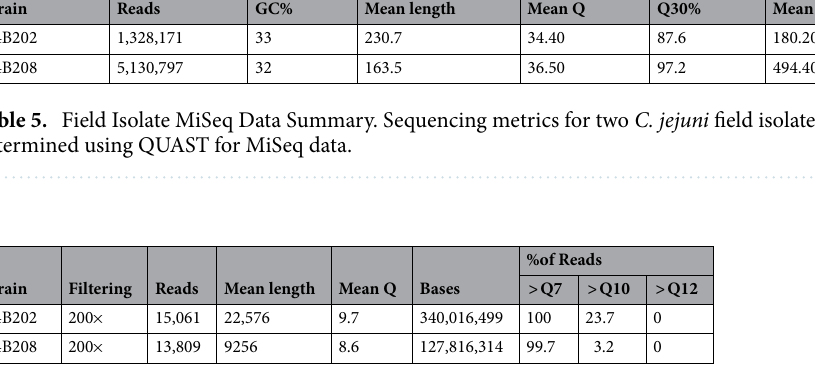
Table 6. Field Isolate MinION Data Summary. Sequencing metrics for two C. jejuni field isolates were determined using NanoStat for MinION data.